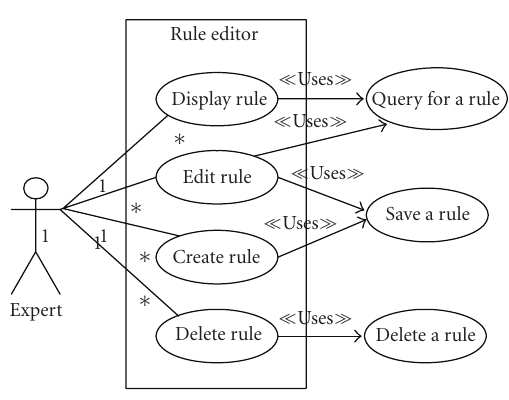
Figure 17: Use case for rule